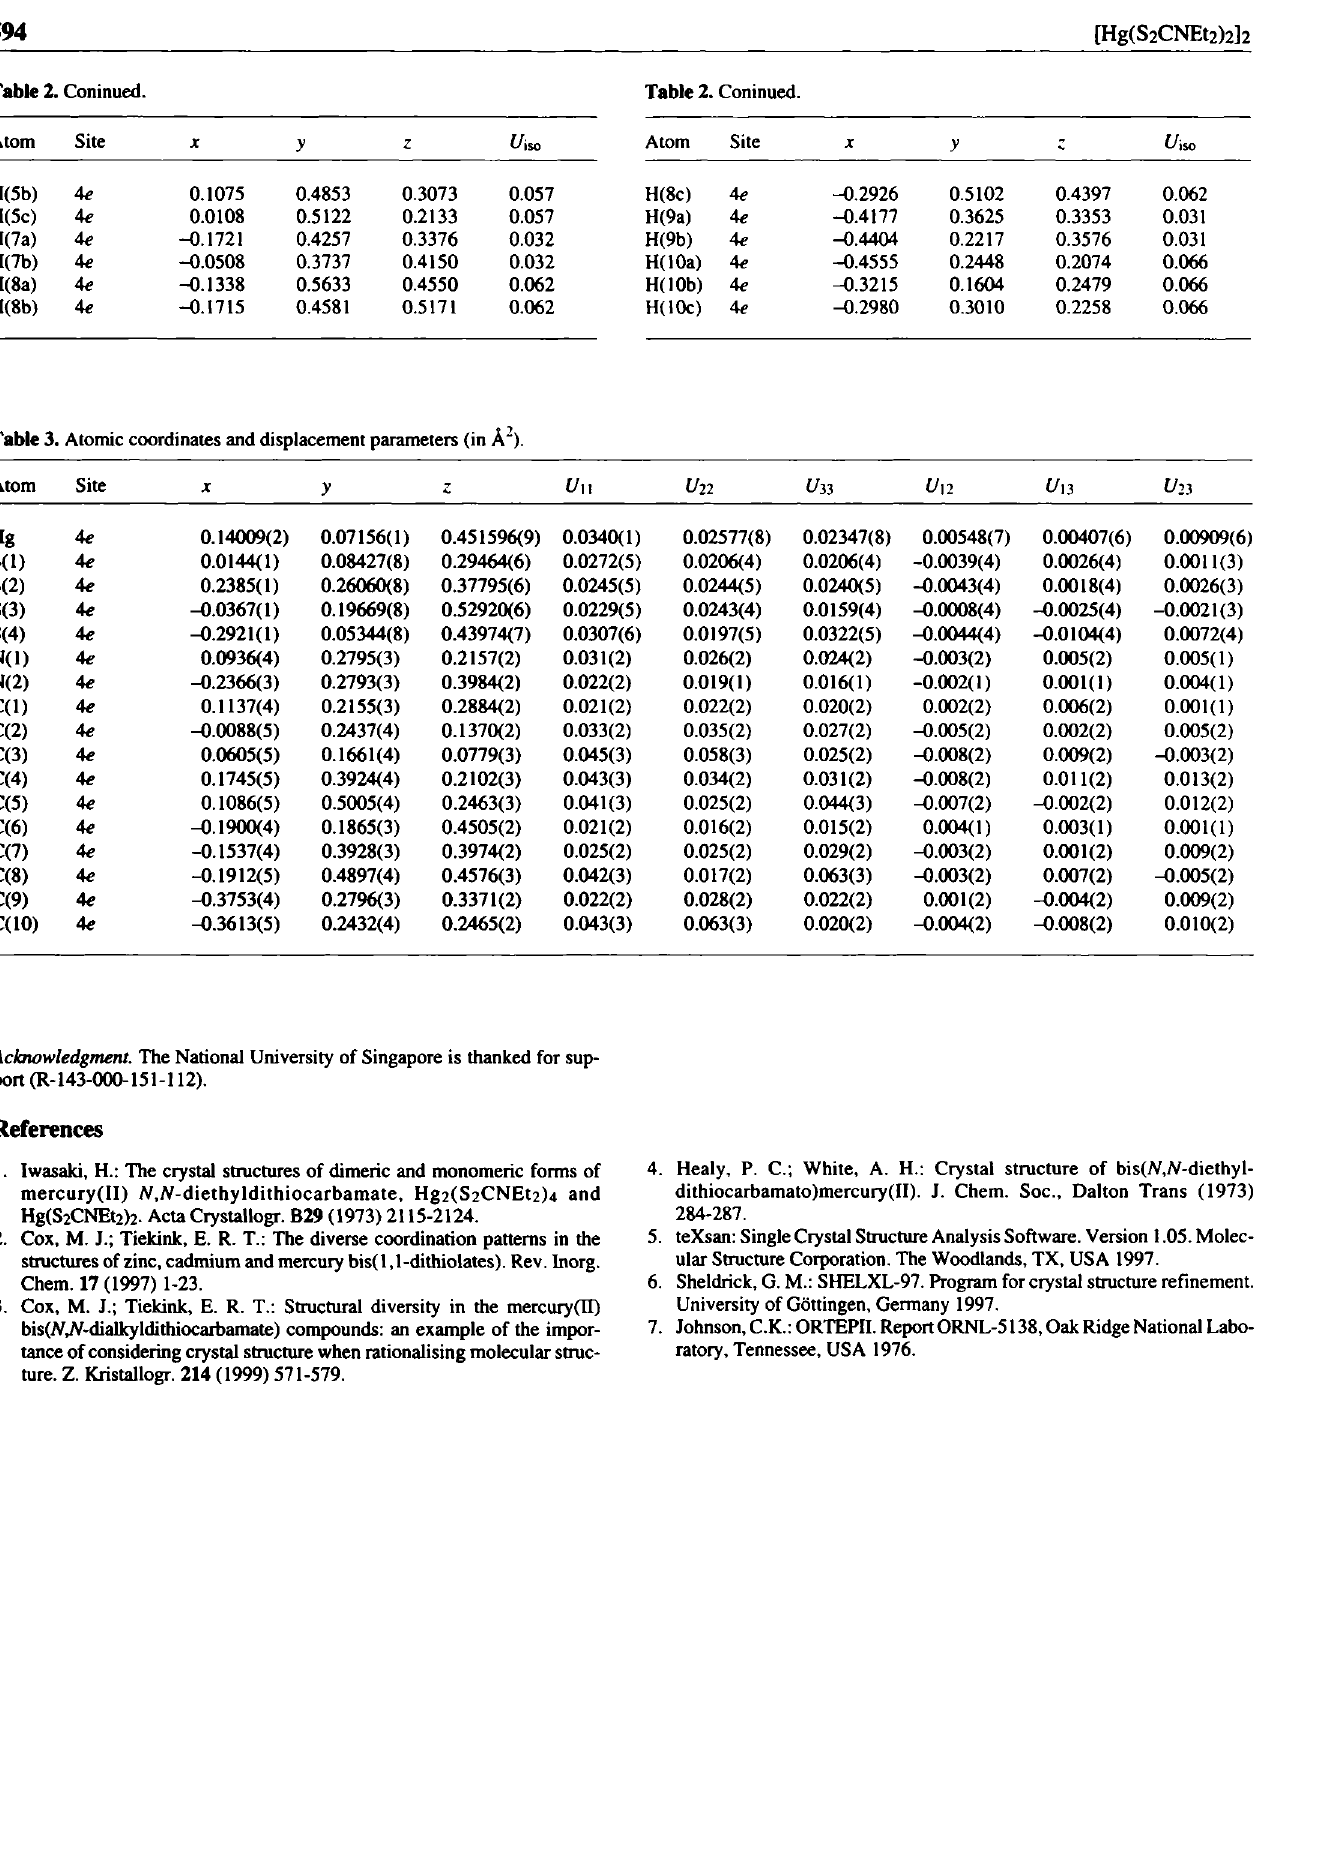
Table 2. Coninued.